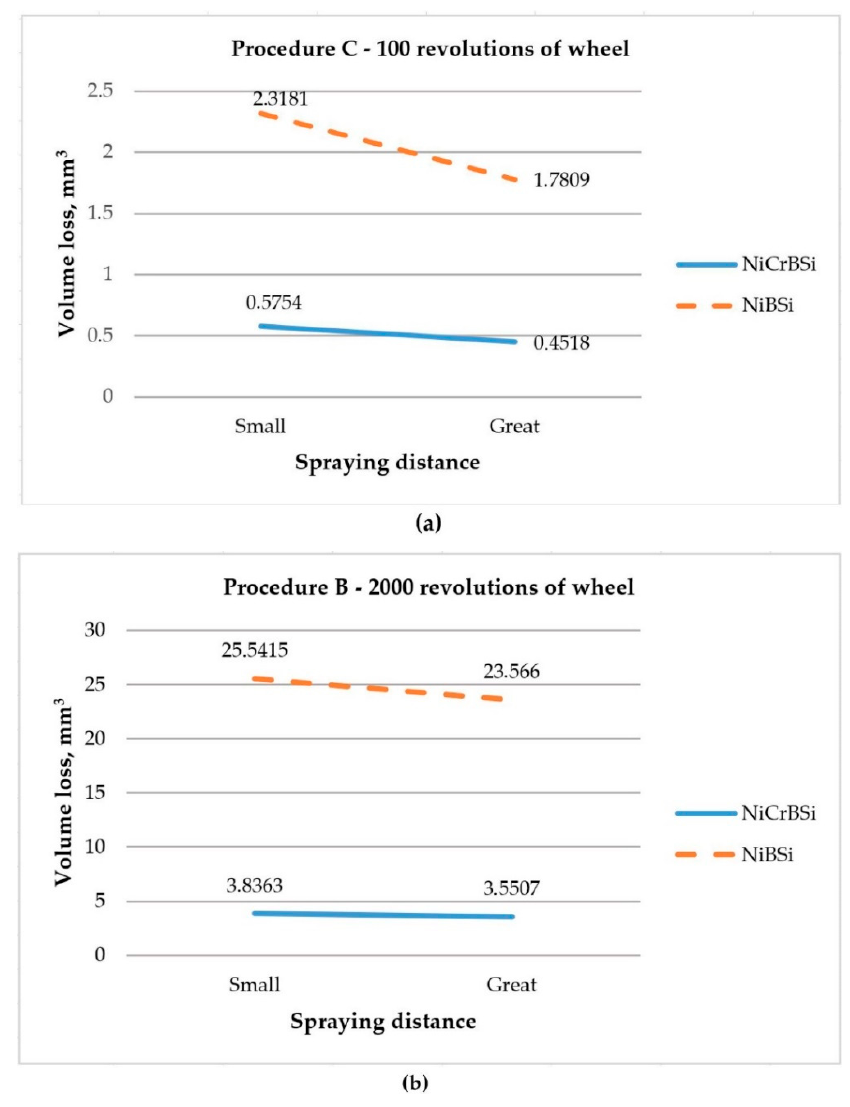
Figure 1. Interaction between spraying distance and type of coating: ( a ) Procedure C; ( b ) Procedure B [11].